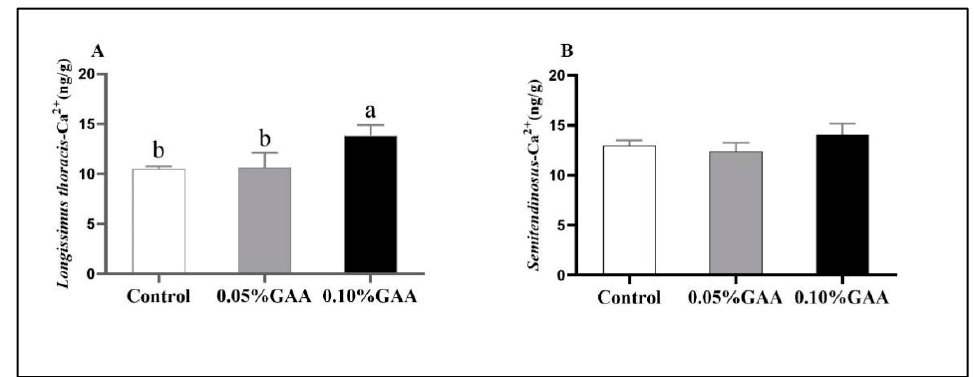
Figure 2. Effects of guanidinoacetic acid supplementation on the sarcoplasmic Ca 2+ contents in ( A ) longissimus thoracis muscle and ( B ) semitendinosus muscle of finishing pigs. Means with different letters differ significantly ( p < 0.05). Values are presented as the mean ± SEM ( n = 5). Control: Finishing pigs were fed a basal diet; 0.05% GAA or 0.10% GAA: Finishing pigs were fed a basal diet supplemented with GAA at 500 or GAA at 1000 mg kg − 1 .